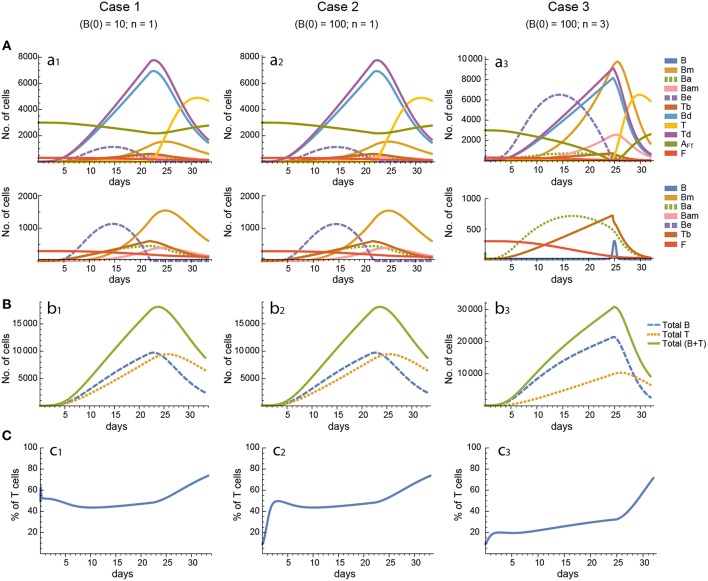
Reference dynamics of model 2. (A) Dynamics of individual compartments. The second row shows in detail the kinetics of those variables reaching low values. (B) Global dynamics. The dynamics of total B cells (BT), total T cells (TT), and total lymphocytes (BT + TT) are shown. (C) Percent of total T cells out of total lymphocytes. Parameter values used: μ1 = 0.22; c1 = 19.04 day−1(molec/GC)−1; c2 = 30.07 day−1(cell/GC)−1; p1 = 1.17 day−1; db = 1.17 day−1; a1 = 17.90 day−1; a1m = 11.94 day−1; a2 = 13.77 day−1; dbm = 3.11 day−1; p2 = 1.04 day−1; dt = 0.15 day−1; Kb = 9782.02 cell/GC; Kt = 598.82 cell/GC.